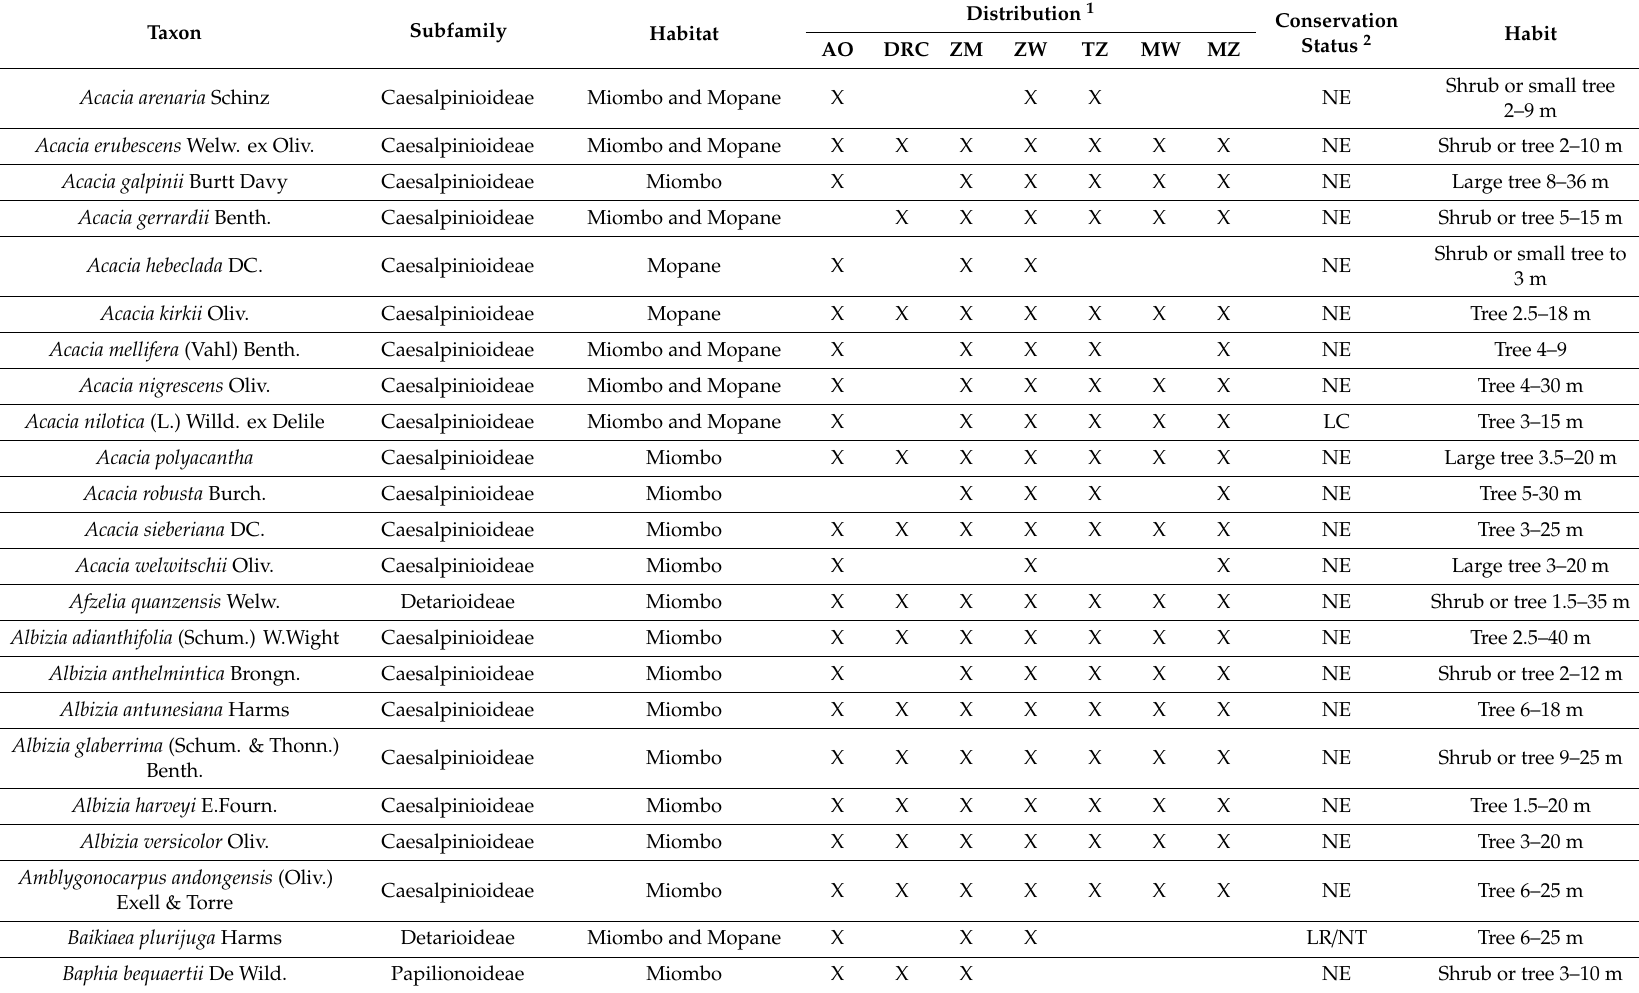
Table 1. Leguminosae tree species from Miombo and Mopane ecosystems: main habitat, distribution in the Zambezian area, conservation status (International Union for Conservation of Nature - IUCN) and